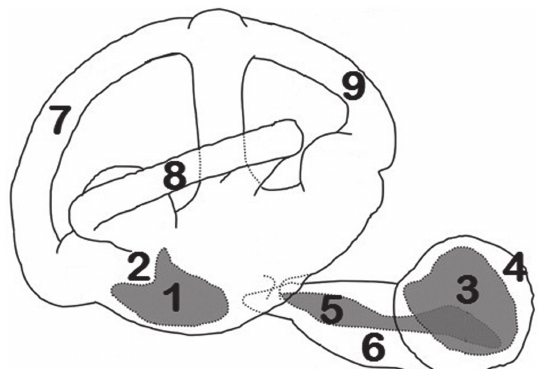
Fig. 1. General structure of the inner ear of a siluriform. 1 , Lapillus; 2 , Utricle; 3 , Asteriscus; 4 , Lagena; 5 , Sagitta; 6 , Saccule; 7 , antero-vertical canal; 8 , horizontal canal; 9 , posterior-vertical canal.